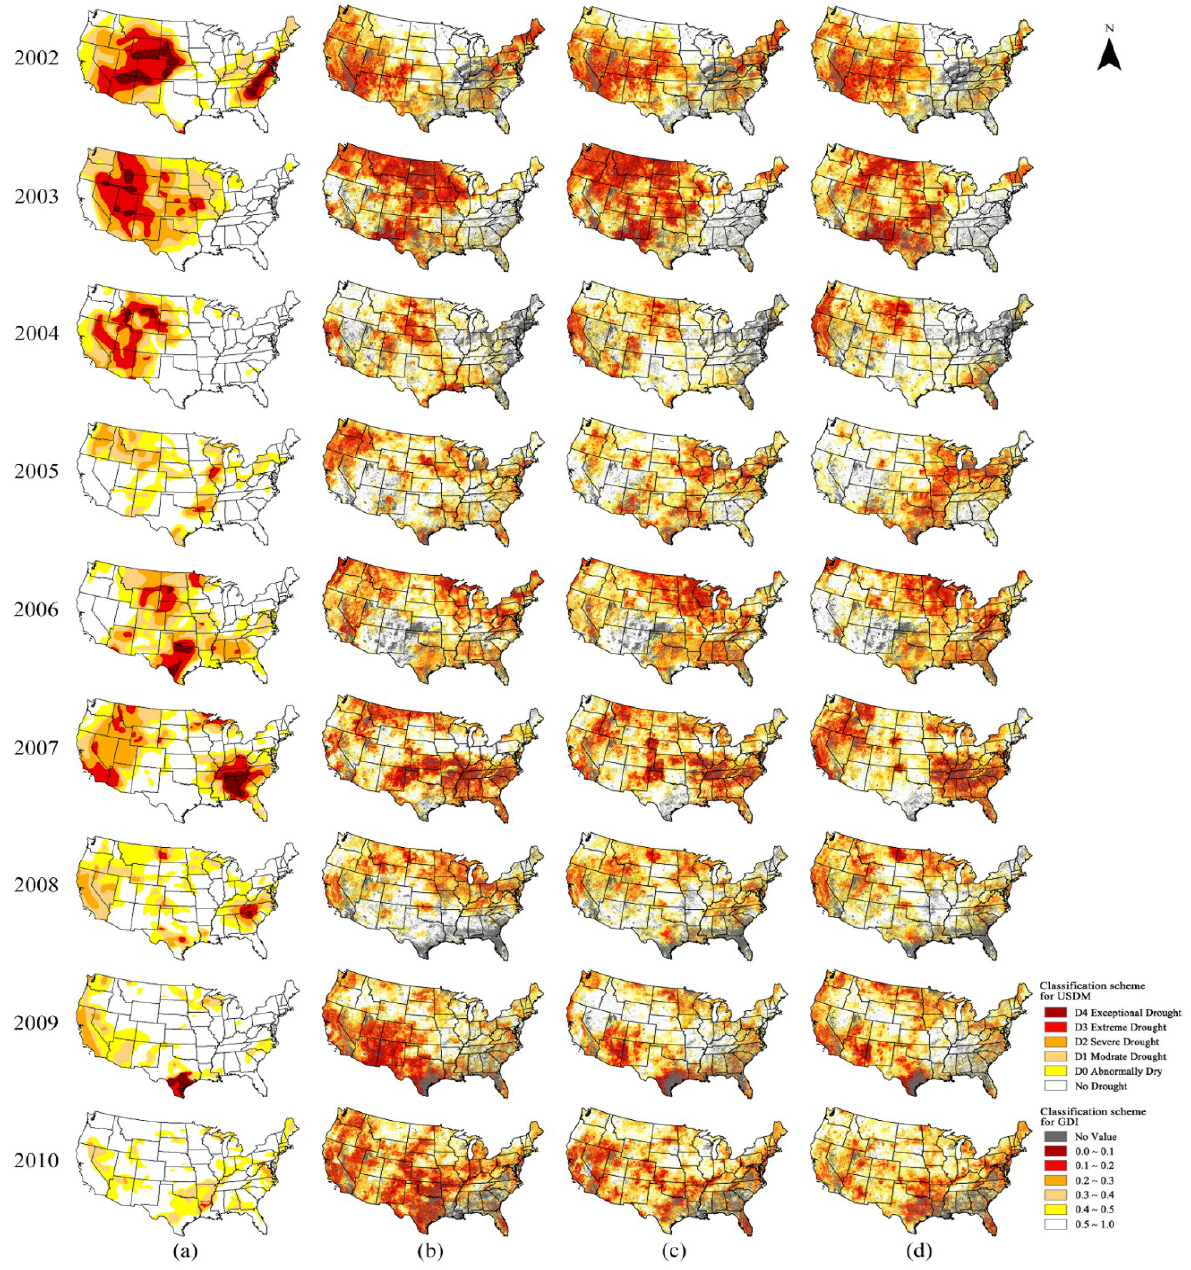
Figure 8. The spatial distribution of the drought indices for 2002–2010. ( a ) USDM; ( b ) GDI-1TRMM; ( c ) GDI-3TRMM; ( d )